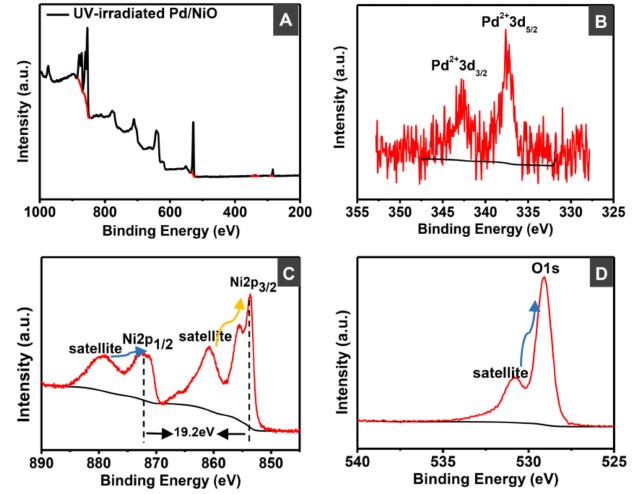
Figure 2. X-ray photoelectron spectroscopy (XPS) spectra of UV-irradiated Pd/NiO